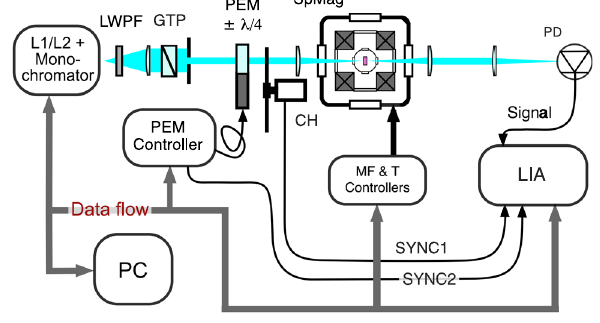
Figure 5. Setup for MCD measurements. L1/L2 - UV Xenon or quartz tungsten lamp, LWPF - long wave pass filter; GTP - Glan-Thompson polarizer; PEM - photoelastic modulator; CH - chopper; SpMag - cryomagnetic system; PD - Si or Ge amplified photo-detector; LIA - multi-frequency lock-in